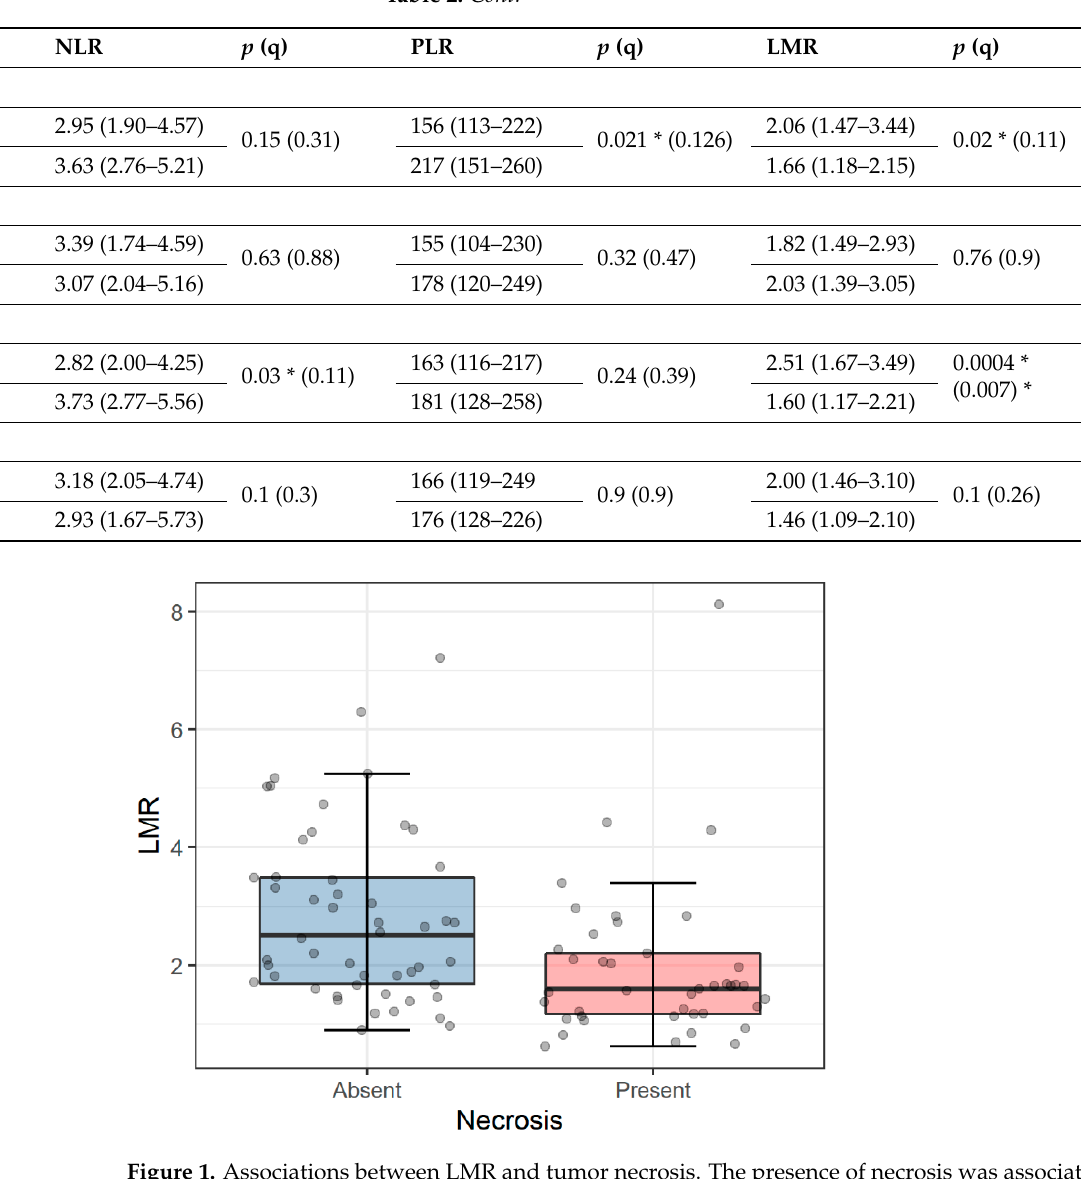
Table 2. Associations between morphological parameters and clinicopathological variables. Given values: median (IQR). p values were calculated with U Mann-Whitney test. q values were calculated with Benjamini-Hochberg correction. *— statistically significant. Abbreviations: LMR: lymphocyte to monocyte ratio; NLR: neutrophil to lymphocyte ratio; PLR: platelet to lymphocyte ratio.